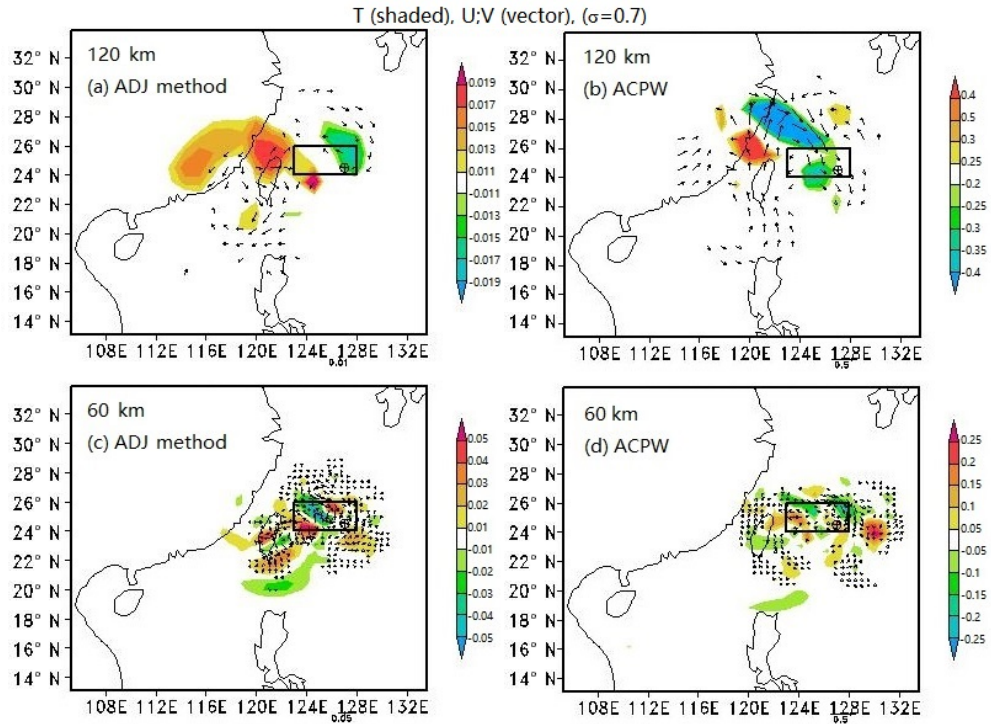
Figure 5. CNOP patterns at σ = 0 . 7 for TC Fitow. The shaded parts represent temperature (units: K), and the vectors describe the wind (units: ms − 1 ). The squares indicate the verification areas, and the initial cyclone positions are shown by ⊕ . Letters (a) and (b) denote the CNOP patterns at the 120km resolution for the ADJ method and the ACPW algorithm, respectively, while letters (c) and (d) represent the CNOP patterns at the 60km resolution for the ADJ method and the ACPW algorithm, respectively.